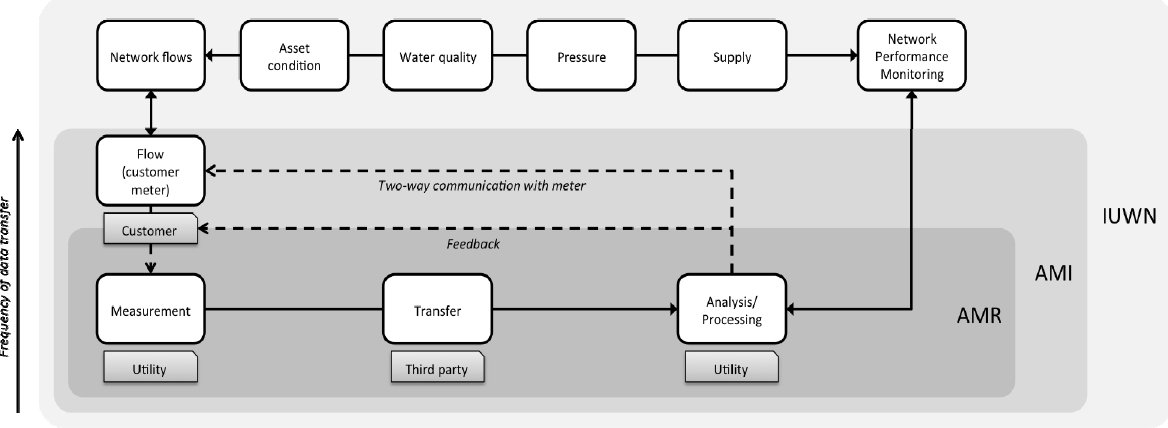
Figure 2. Conceptualising intelligent metering as Automated Meter Reading (AMR), Advanced Metering Infrastructure (AMI) and within an intelligent urban water network